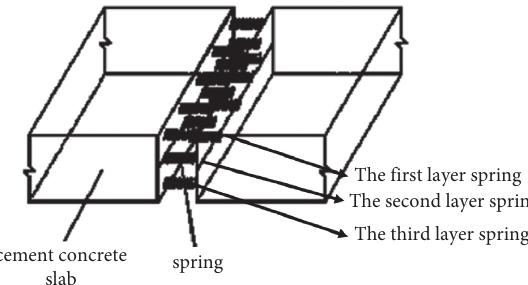
Figure 6: Schematic diagram of using spring to simulate load transfer at the